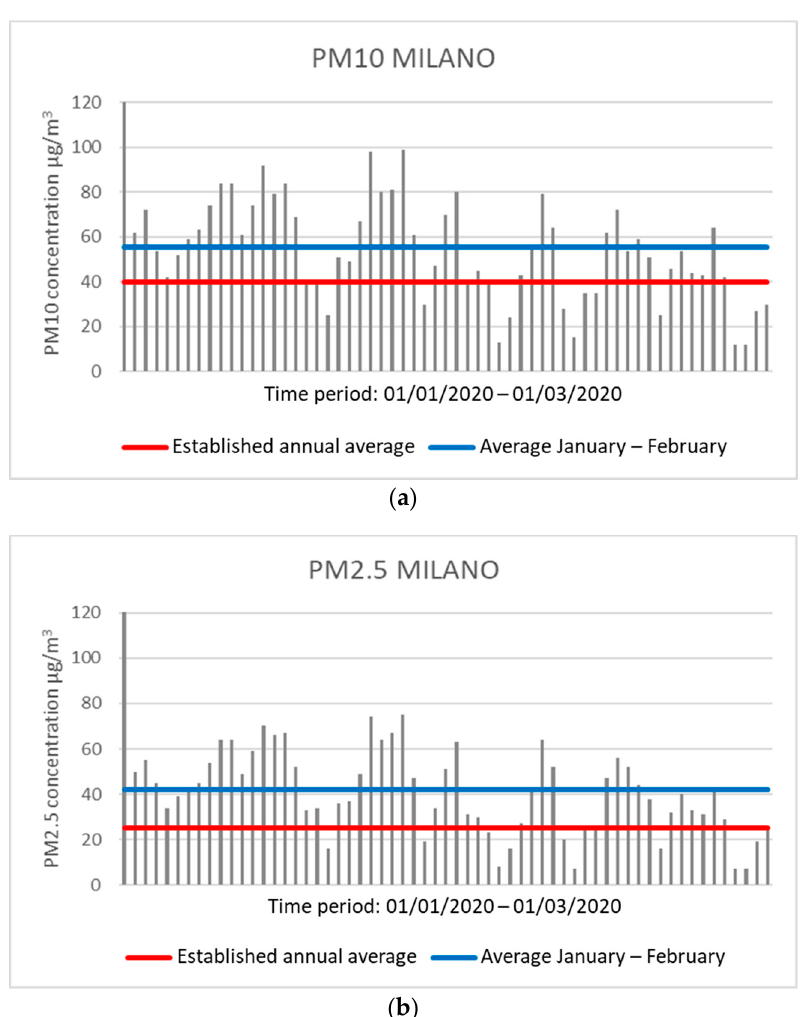
Figure 2. Graphs showing the concentration values of PM10 (a) and PM2.5 (b) in Brescia. The red line indicates the expected regulatory limit, while the blue line indicates the average in the two months analyzed (analysis processed with data collected by ARPA).